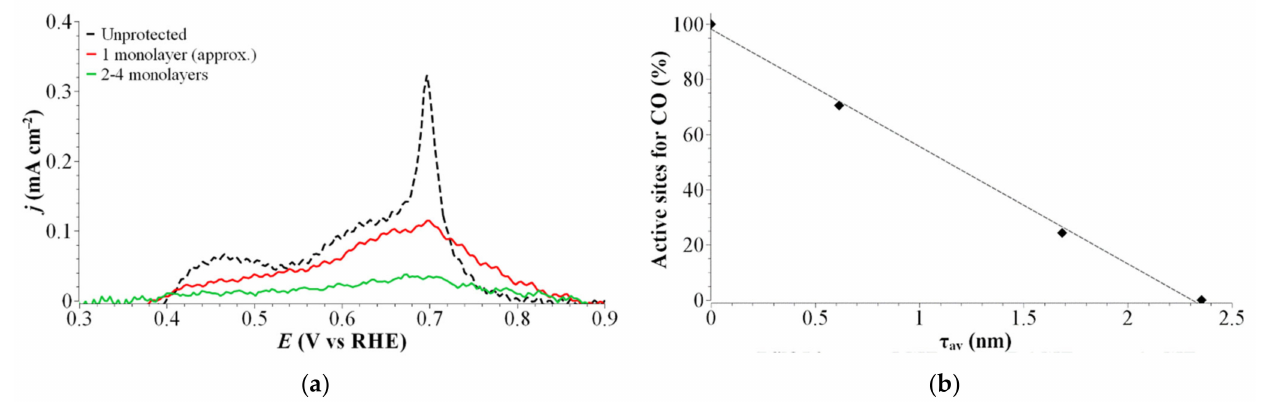
Figure 4. The ( a ) CO stripping peaks obtained from the CVs after poisoning for 15 min at 20% CO/N 2 , E = 0.05 V vs. RHE, followed by N 2 flush for another 15 min at the same potential and ( b ) loss of active sites determined from oxidation of adsorbed CO, with linear